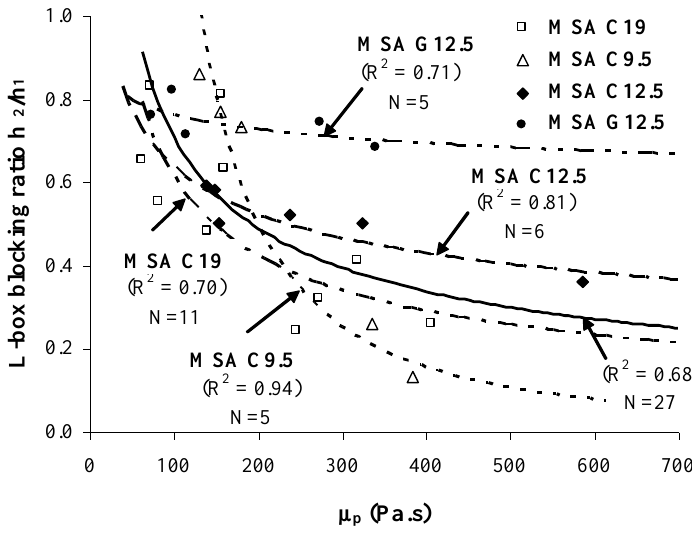
Figure 7. Relationship between plastic viscosity and L-box blocking